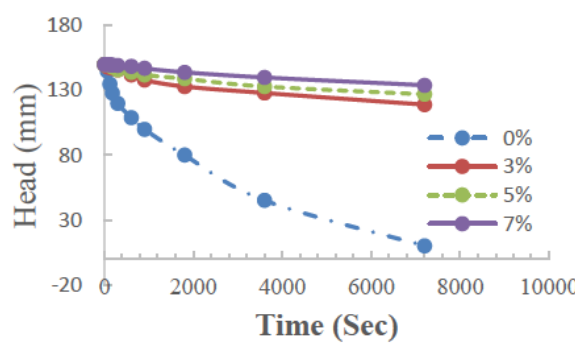
Figure 7: Relationship between falling water in a pipe for the con- stant head permeability test and the duration of time for untreated and 3%, 5%, and 7% stabiliser-treated soil after 3 days of soaking